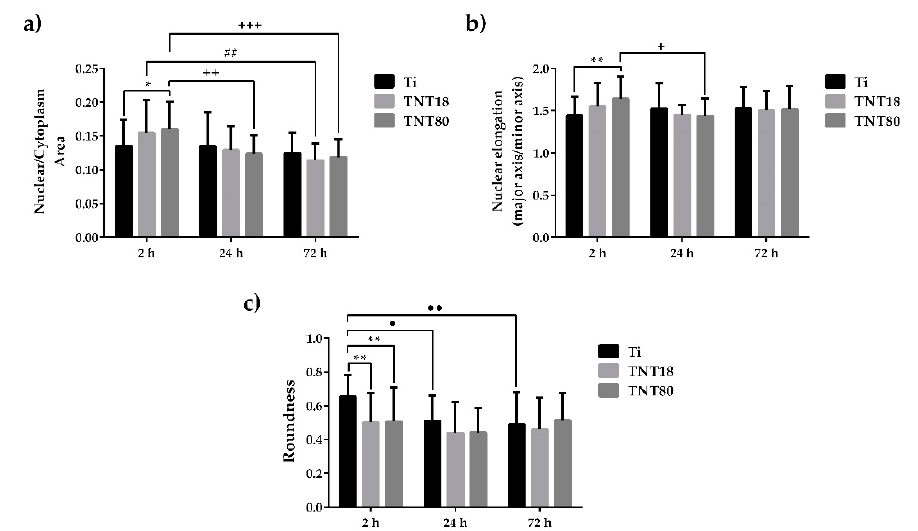
Figure 5. Cellular morphology parameters evaluated at 2 h, 24 h and 72 h post-seeding. ( a ) Quantification of Nuclear-Cytoplasmic area ratio. Results are presented as means ± SD (n = 30 cells, * p < 0.05 compared with Ti; ## p < 0.01 between TNT18 at 24 h vs. 72 h; ++ p < 0.01, +++ p < 0.001 between TNT80 at 2 h vs. 24 h, and 2h. vs. 72 h, respectively); ( b ) Nuclear elongation measurement calculated as the ratio between major axis and minor axis. Results are presented as means ± SD (n = 30 cells, ** p < 0.01 compared with Ti; + p < 0.05 between respective groups at 2 h vs. 24 h); ( c ) Quantification of cell roundness. Results are expressed as means ± SD (n = 30 cells, ** p < 0.01 compared with Ti; ● p < 0.05, ●● p < 0.01 comparation between Ti at 2 h vs. 24 h, and 2h vs. 72 h, respectively).